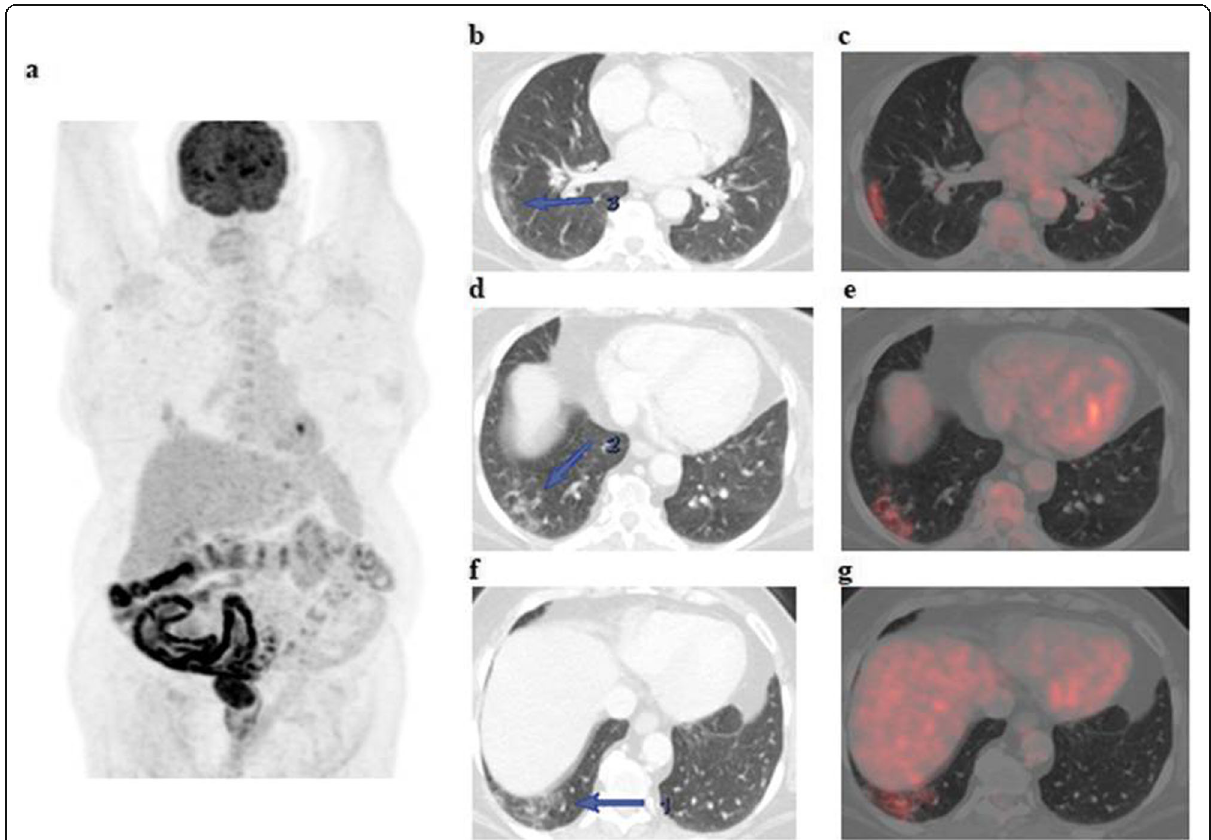
Fig. 7 A 75-year-old female patient, with a history of lymphoma, received chemotherapy and referred for follow-up PET/CT evaluation. a The whole-body MIP image shows mildly active areas at the right lung lower zone. Axial lung window CT images ( b , d , f ) revealed few unilateral subpleural variable-sized ill-defined ground-glass opacities at the right lower lung lobe that show mild FDG uptake in corresponding fused PET/ CT images ( c , e , g ) achieving up to 4.5